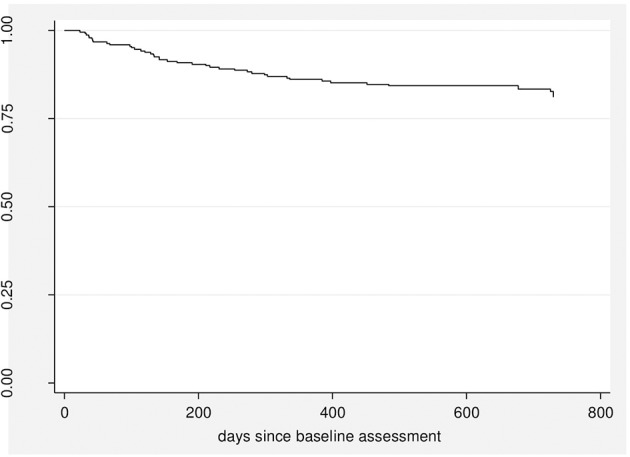
Kaplan-Meier estimates of the risk of developing psychotic disorder.